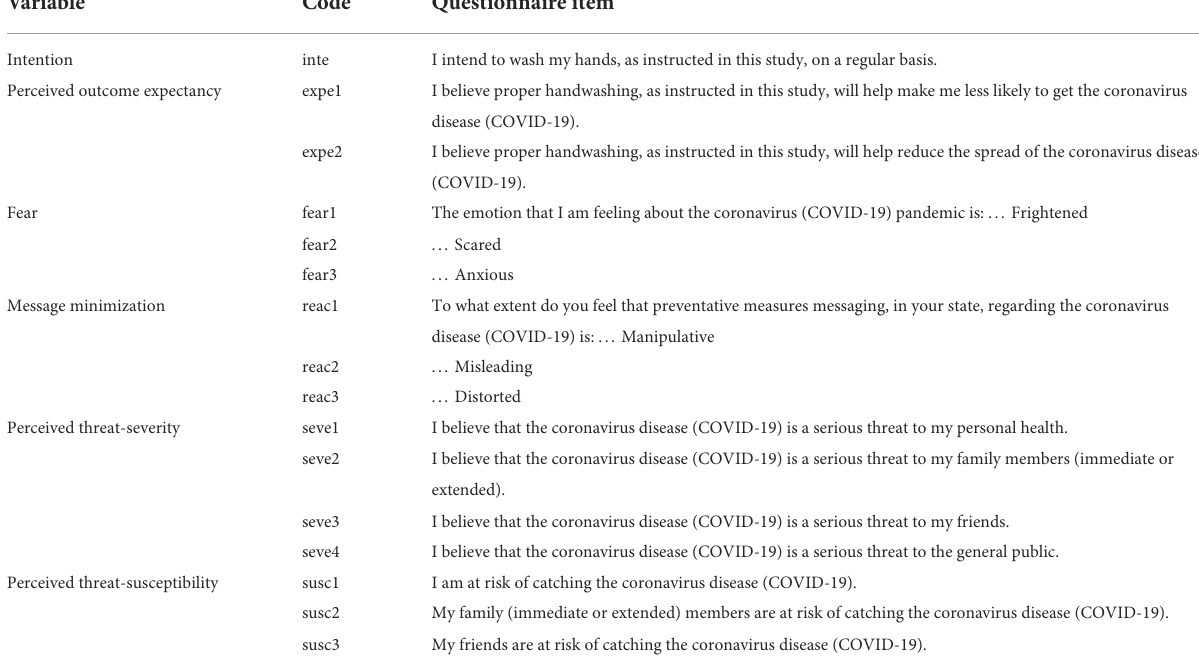
TABLE 1 Study 1 questionnaire